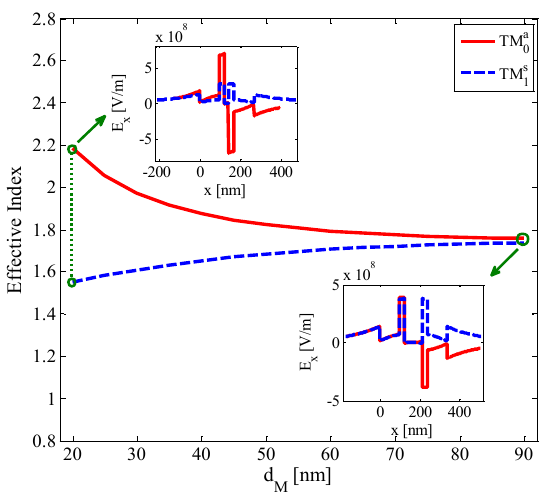
Figure 3: Effective refractive index and Normal electric field (E x ) profile of the first two TM polarized hybrid-guided modes of the HIMI slab waveguide in terms of d M for d H =100 nm and d L =25 nm. compared to other common metals used in